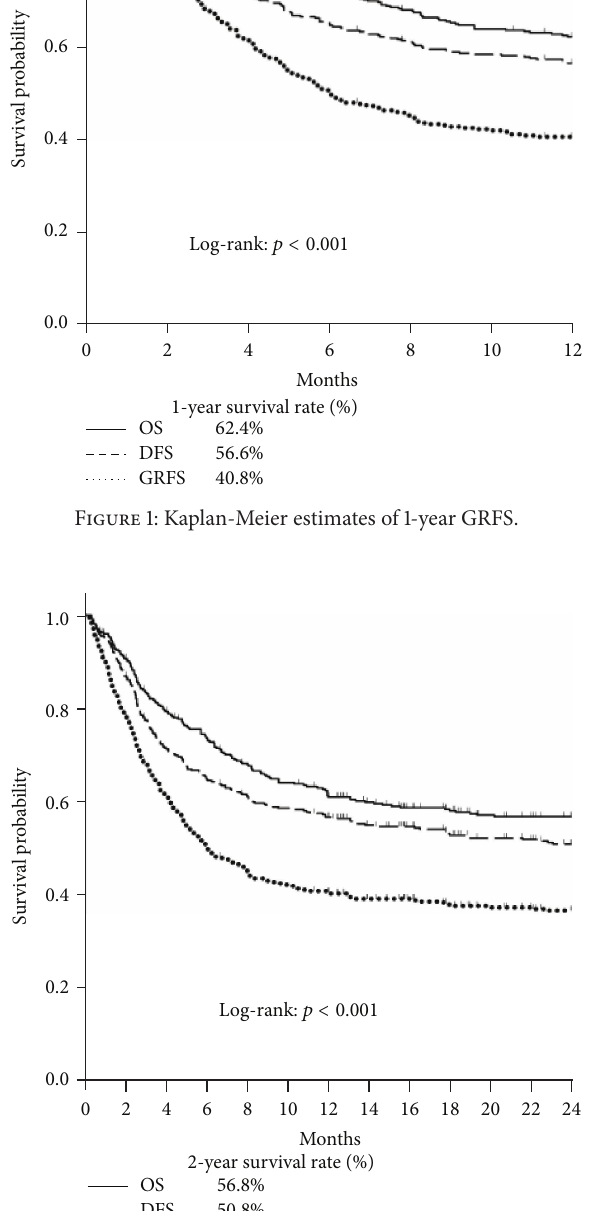
GRFS (40.8% versus 31%) and 2-year GRFS of our patients